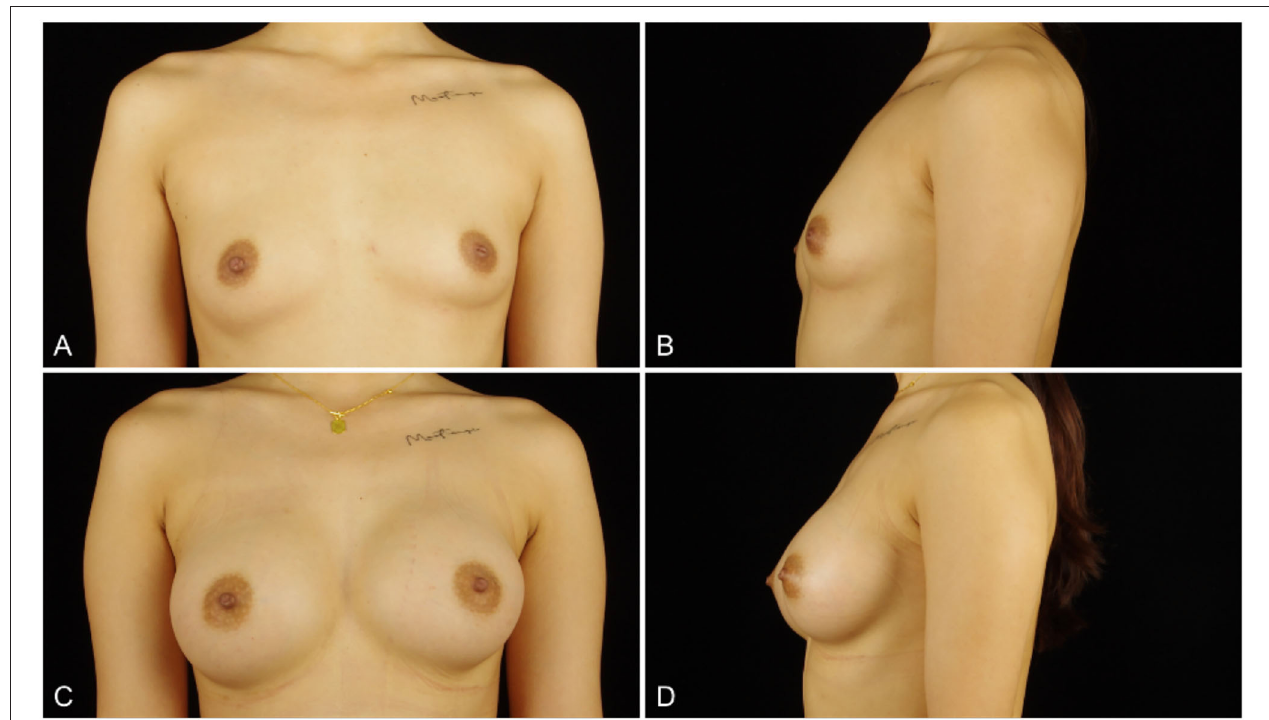
FIGURE 5 | (A,B) a 26-years-old woman (height, 167cm; weight, 55kg; body mass index, 19.7 kg/m 2 ) presented for endoscopic transaxillary breast augmentation with shaped gel implants (Mentor, smooth round moderate 295 cc implants, placed bilaterally). (C,D) Three months